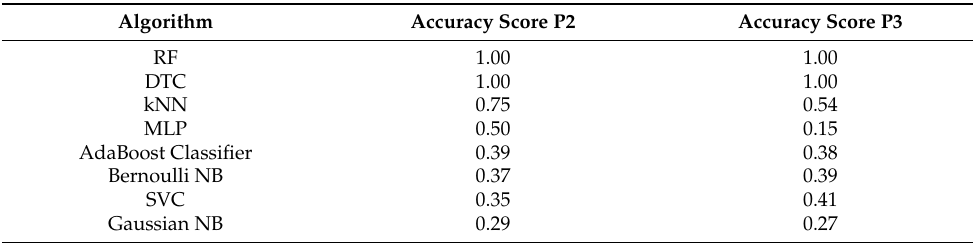
Table 5. Results of the accuracy_score of the tested algorithms in the second